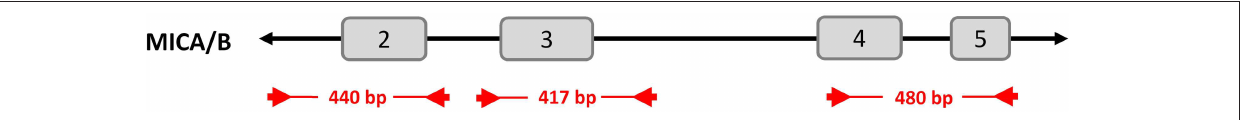
Frontiers in Immunology |